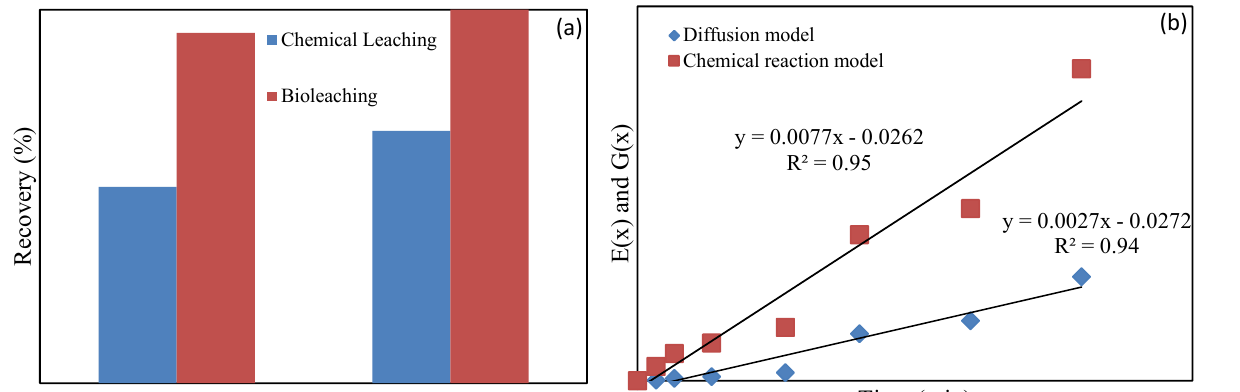
Fig. 5. Comparison between bioleaching and chemical